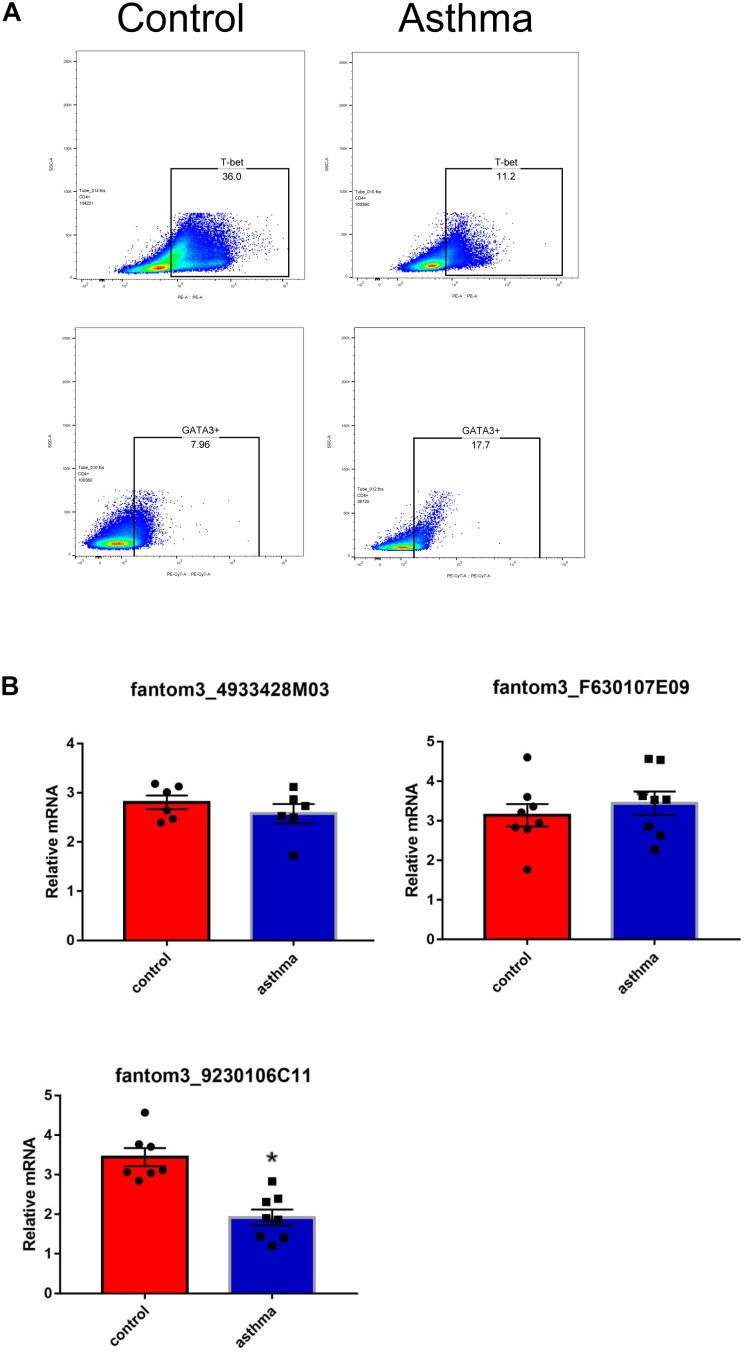
Measurement of selected lncRNAs using qRT-PCR ex vivo. (A) CD4+ T cells in the asthma had lower T-bet and increased Gata-3 expression. Representative result for 3 independent experiments. (B) The expression of randomly selected lncRNAs in CD4+ T cells between the asthma and control groups were quantified ex vivo. ∗p < 0.05, 6∼8 samples were analyzed in each group.